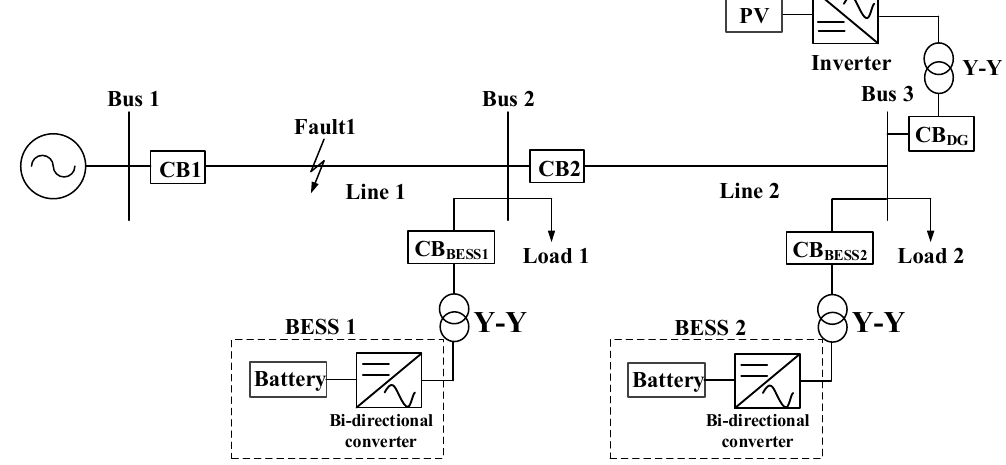
Figure 1. Distribution system model with distributed generation (DG) and a battery energy storage system (BESS).